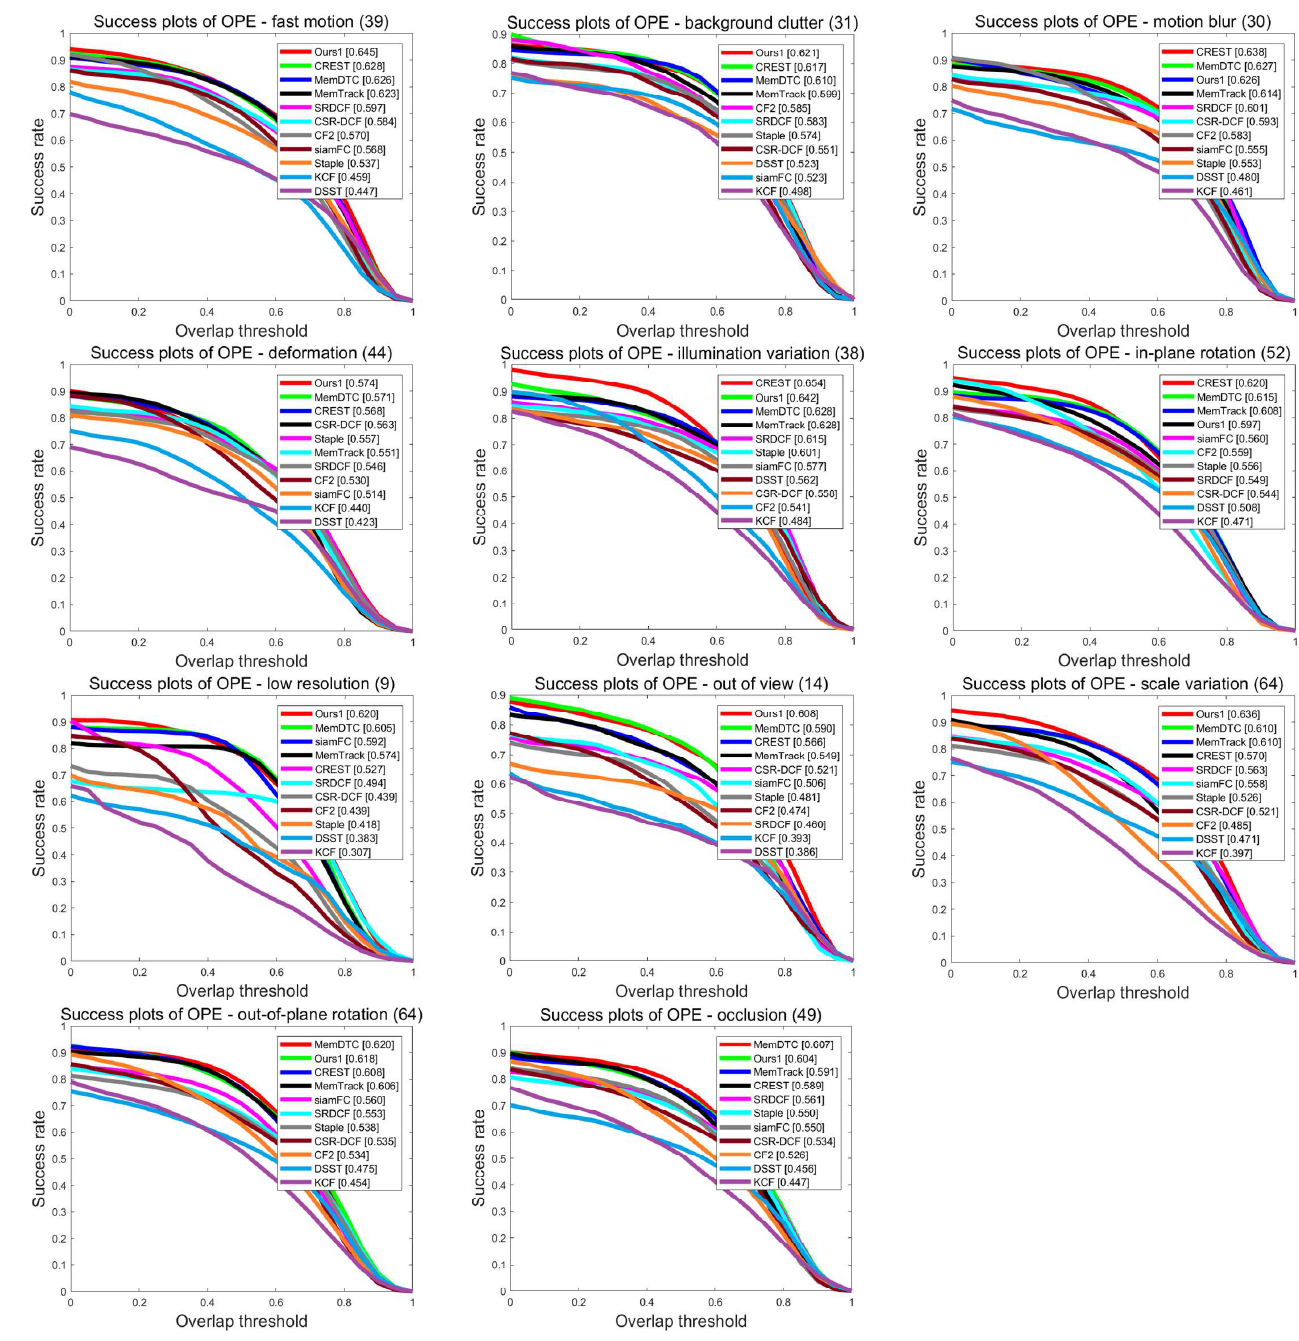
Figure 8. Comparison of 11 attribute challenge